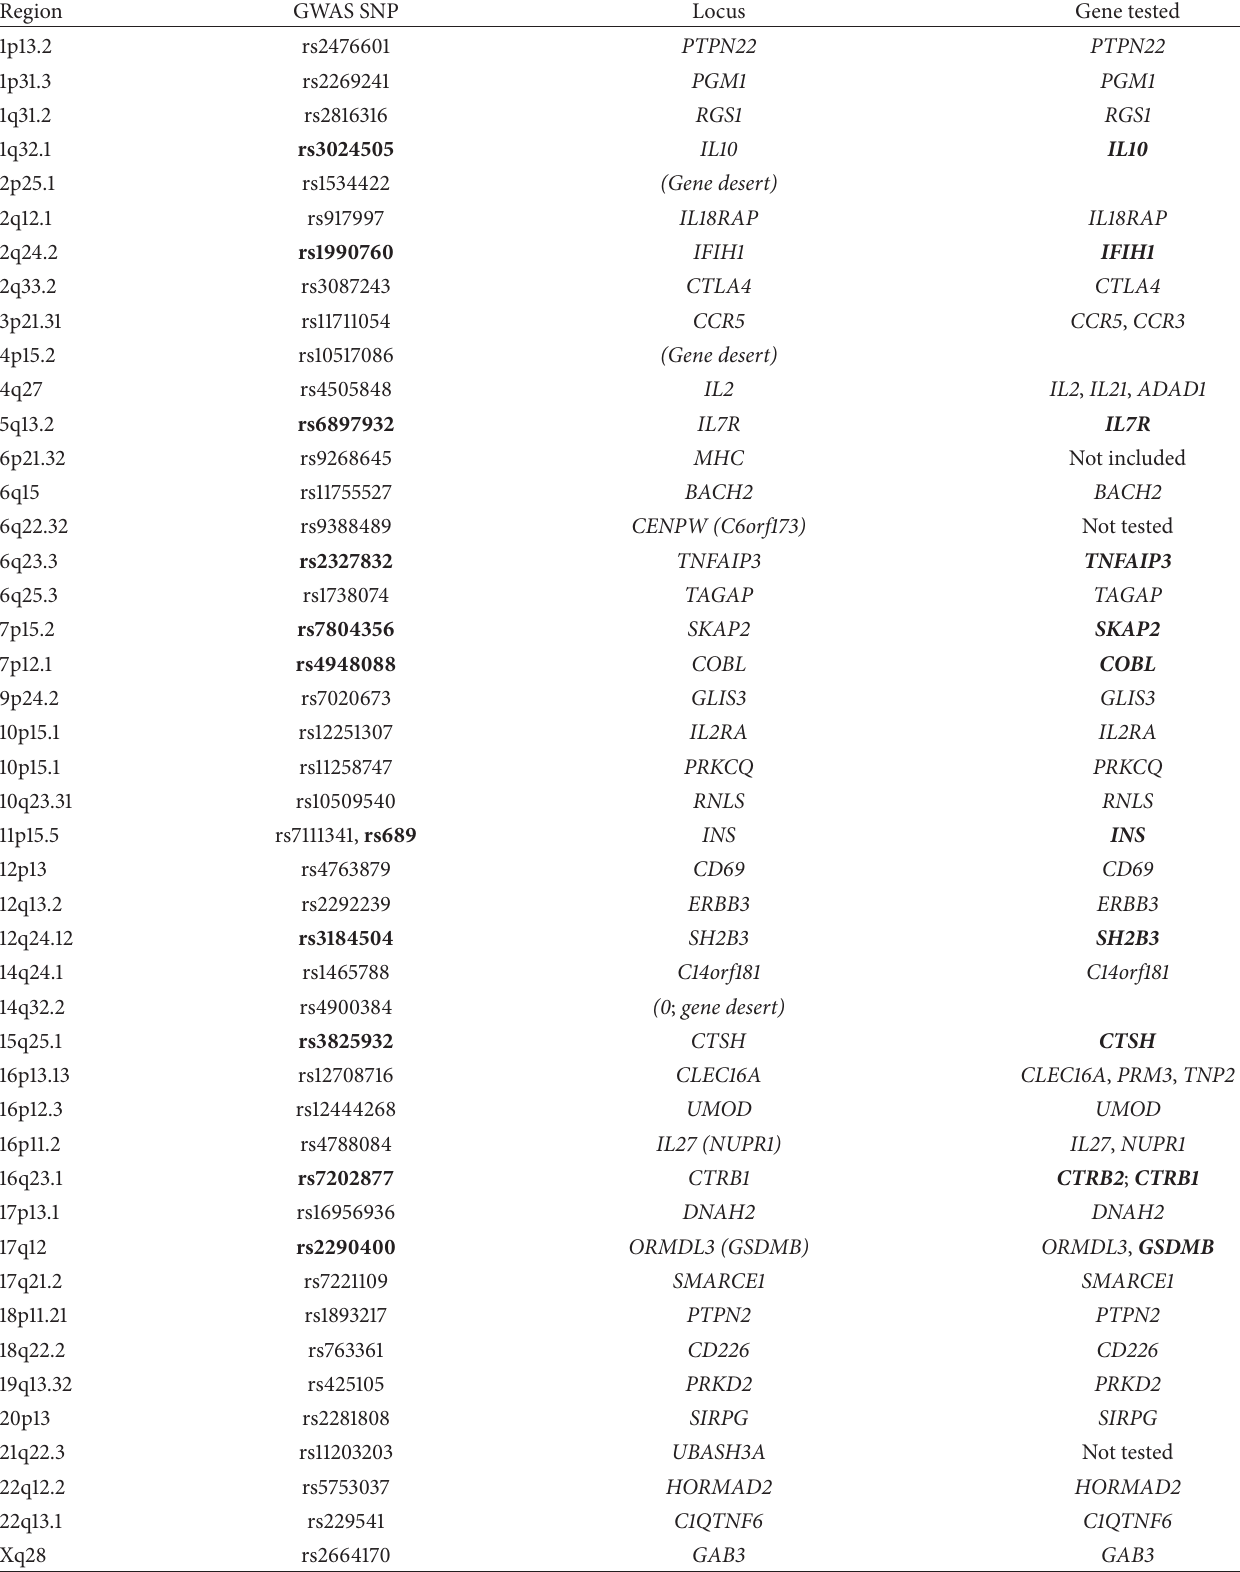
Table 1: The 46 T1D candidate genes tested for expression and cytokine regulation in human